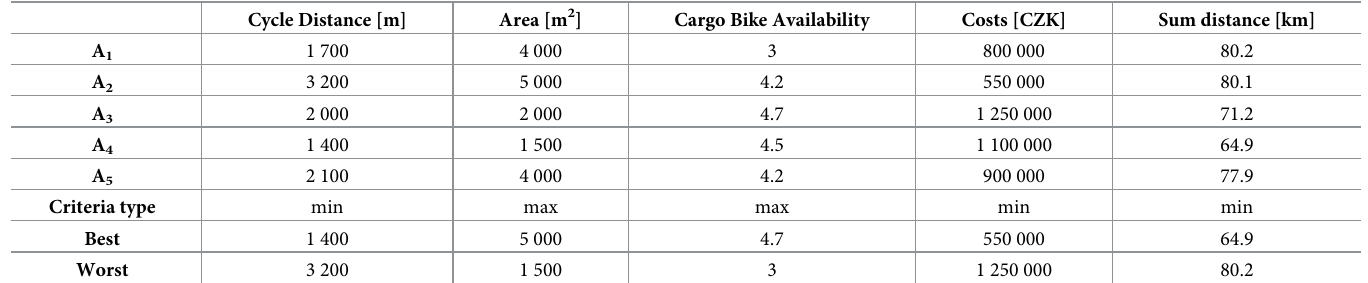
Table 12. The initial CRITIC decision-making matrix.